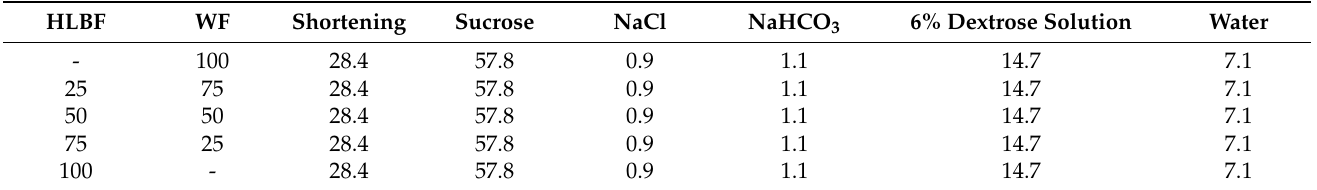
Table 7. Formulation of composite cookies containing wheat flour (WF) and hulless barley flour (HLBF)